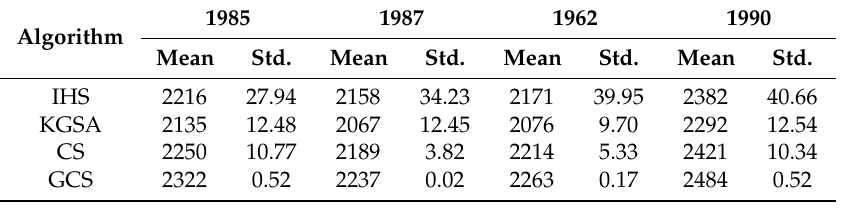
Table 4. Comparison of power generation (10 8 kWh) in wet years.